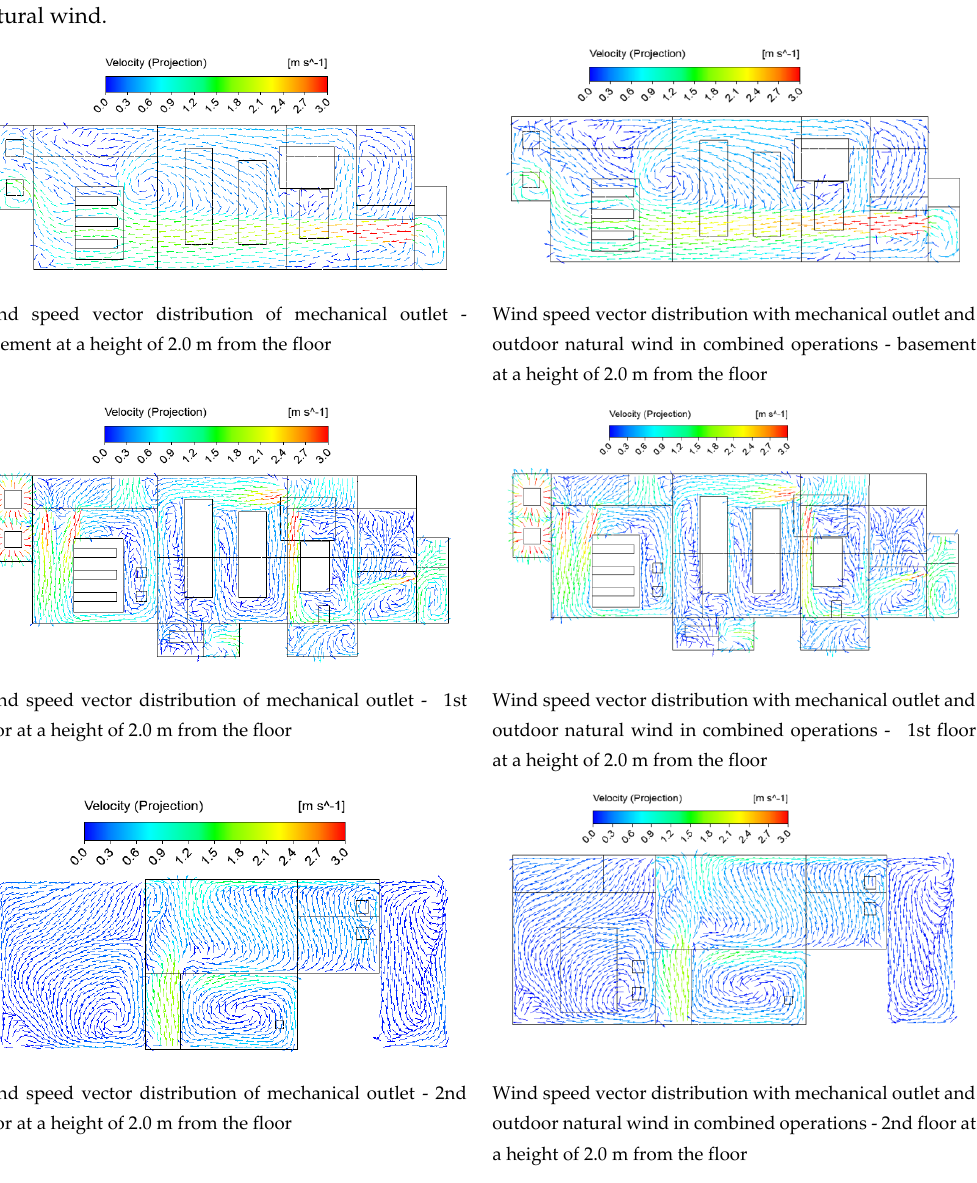
Figure 12. Wind speed vector distributions based on mechanical outlet or mechanical outlet + outdoor natural